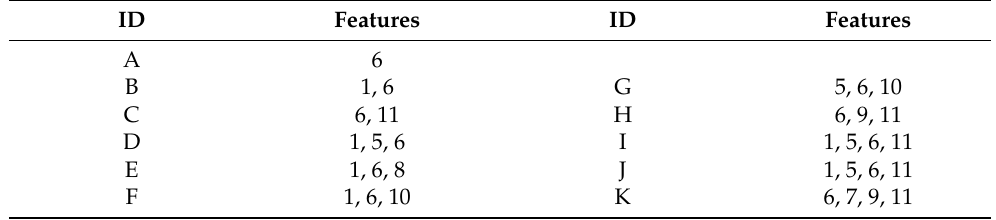
Table 2. Top feature